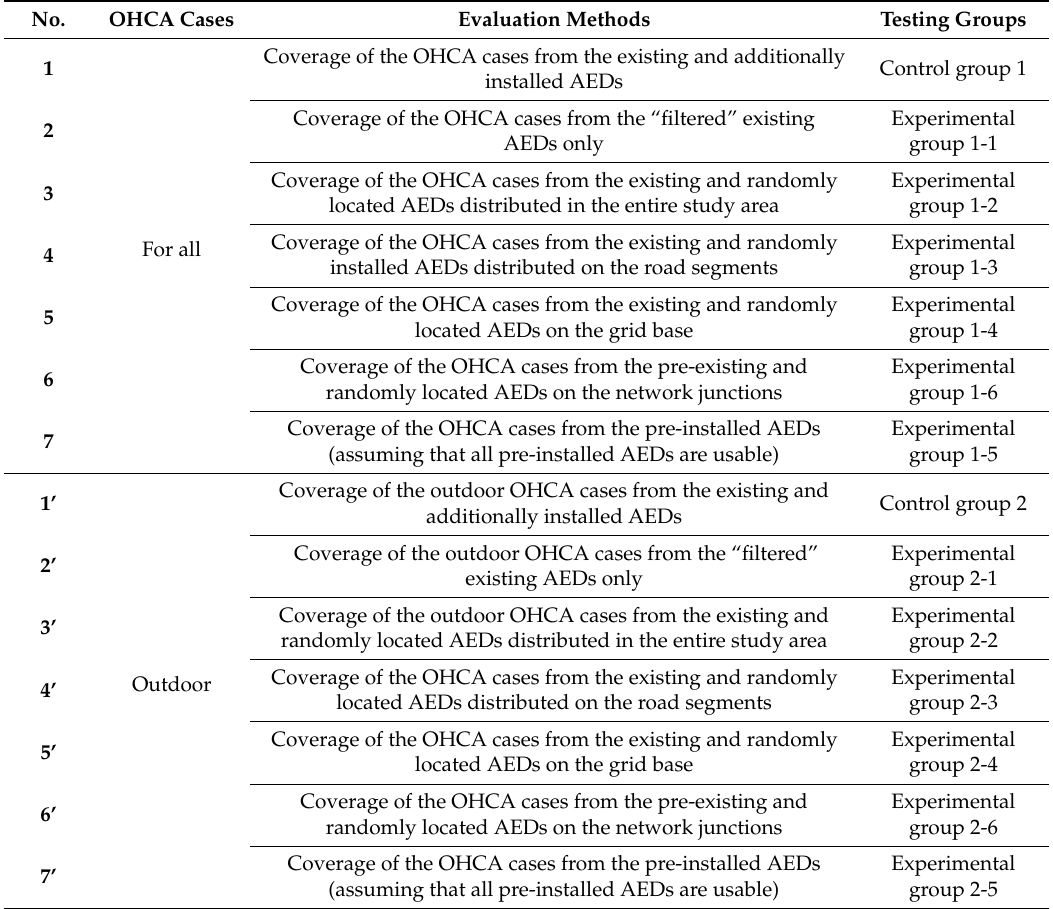
Table 1. Evaluation methods (control and experimental groups).